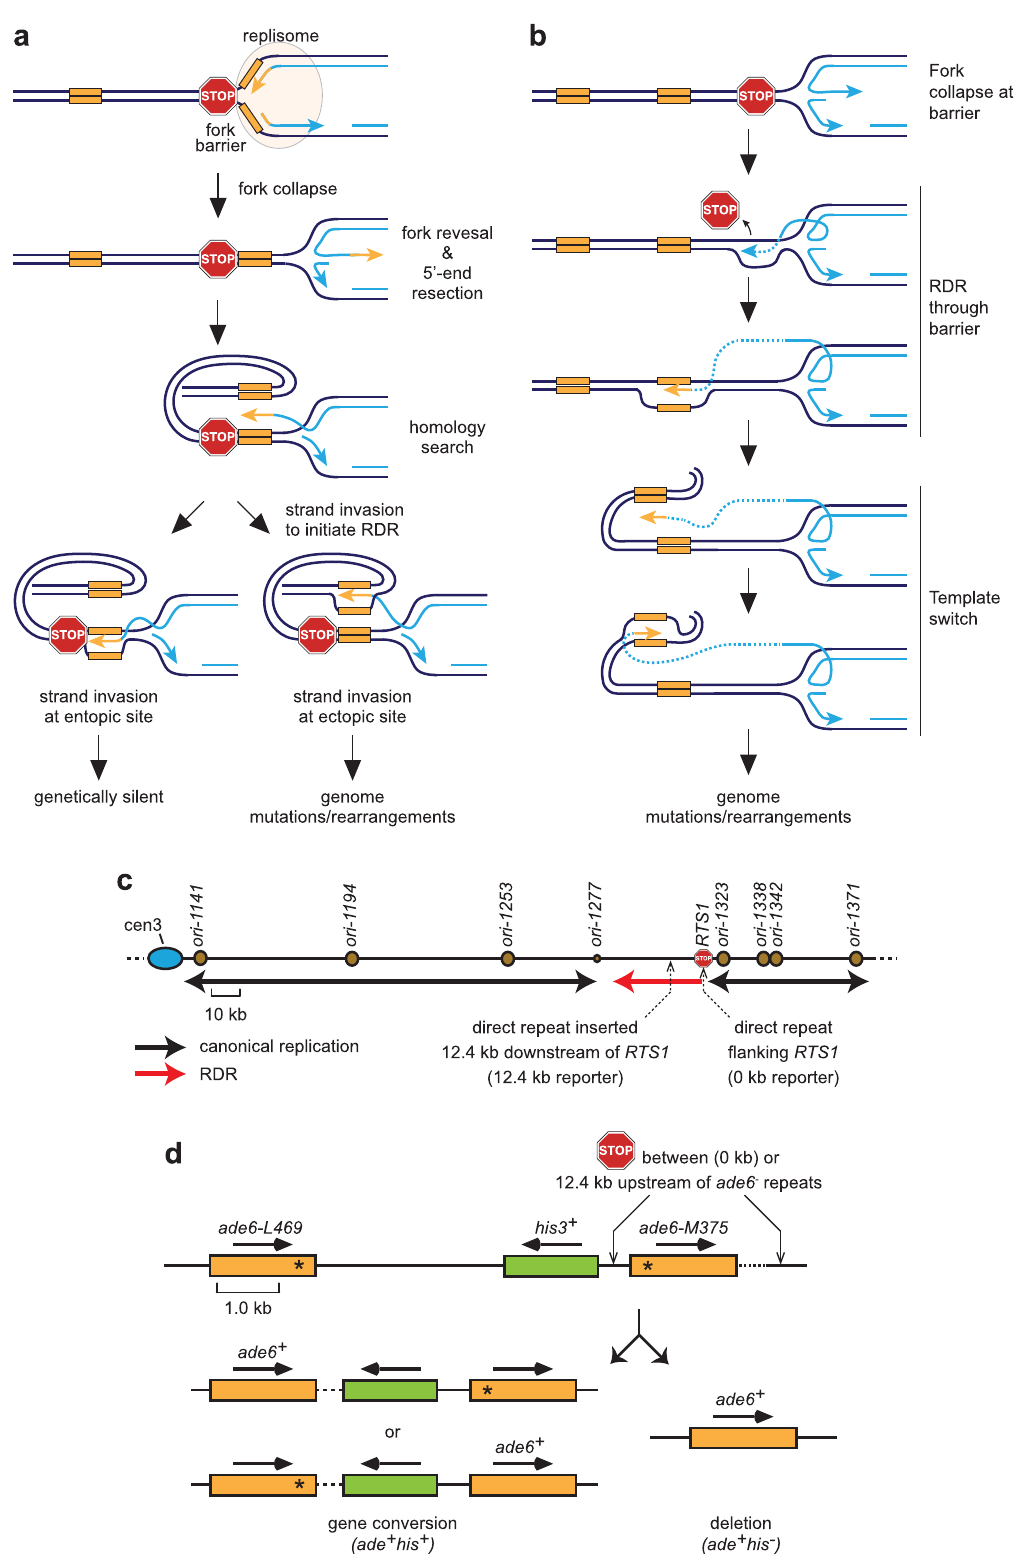
Fig.1|ExperimentalsystemformeasuringRDR-associatedtemplateswitching. a Model for ectopic recombination between repetitive DNA induced by fork col- lapseataRFB.ParentalDNAstrandsareindarkblue,nascentDNAstrandsarelight blue, directly repeated DNA elements are in yellow and the RFB isindicated by the stop symbol. b Model for template switching between direct repeats associated with RDR. c Map of the chromosome 3 region where RTS1 and 0kb and 12.4kb